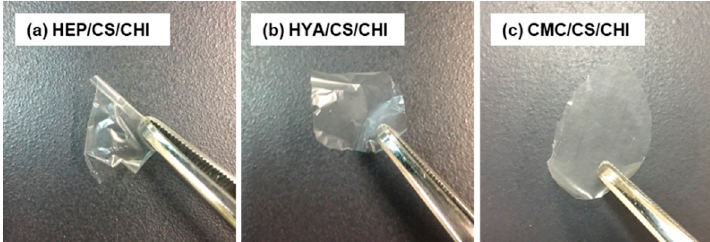
Figure 7. Macroscopic images of polysaccharide composite films made of HEP/CS/CHI ( a ), HYA/CS/CHI ( b ), and CMC/CS/CHI ( c ).